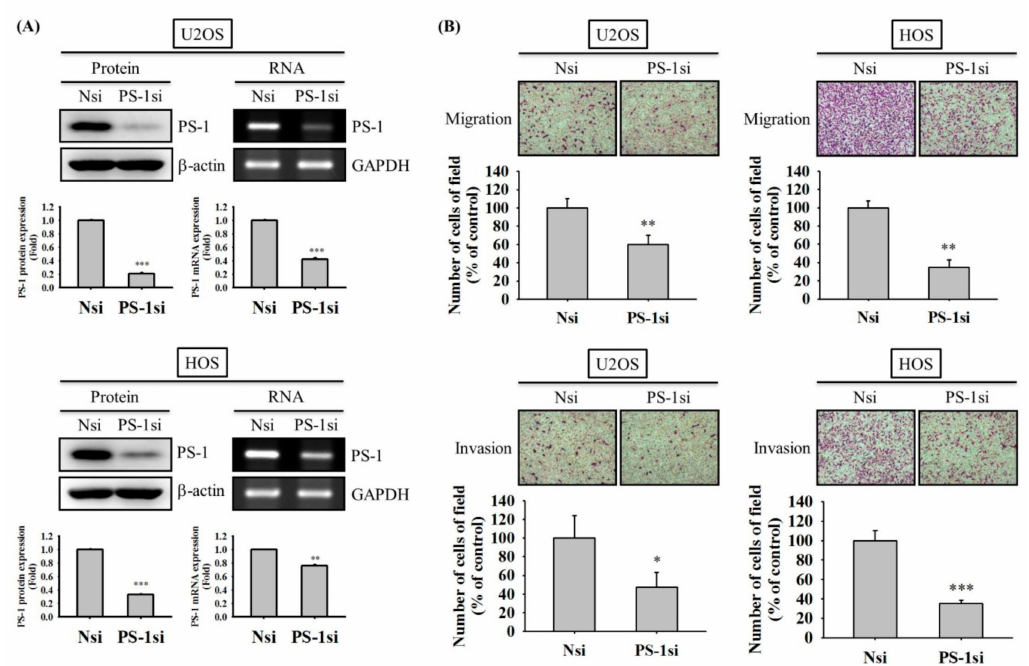
Figure 4. E ff ects of PS-1 knockdown on migration and invasion of U2OS and HOS cells. Using Reverse Transcription-Polymerase Chain Reaction (RT-PCR) to confirm siRNA directly against PS-1 expression ( A ), modified Boyden chamber assays without and with Matrigel coating after treatment of PS-1 siRNA for 48 h in ( B ) U2OS and HOS cells were conducted and the e ff ects were illustrated after quantitative analysis. The results are shown as mean ± S.D. n = 3. Student’s t-test was used. ( A ) U2OS: protein: p < 0.001 and RNA: p < 0.001, HOS: protein: p < 0.001 and RNA: p = 0.002; ( B ) U2OS: migration: p = 0.008 and invasion: p = 0.034, HOS: migration: p = 0.001 and invasion: p < 0.001. *Significantly di ff erent: p < 0.05, **Significantly di ff erent: p < 0.01, ***Significantly di ff erent: p < 0.001, when compared with the control group (Non-siRNA). Nsi: non-small interfering RNA; PS-1si: presenilin-small interfering